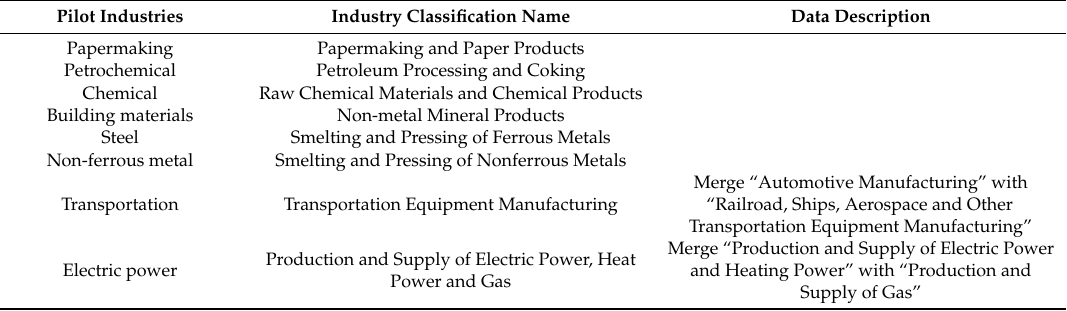
Table A2. List of pilot